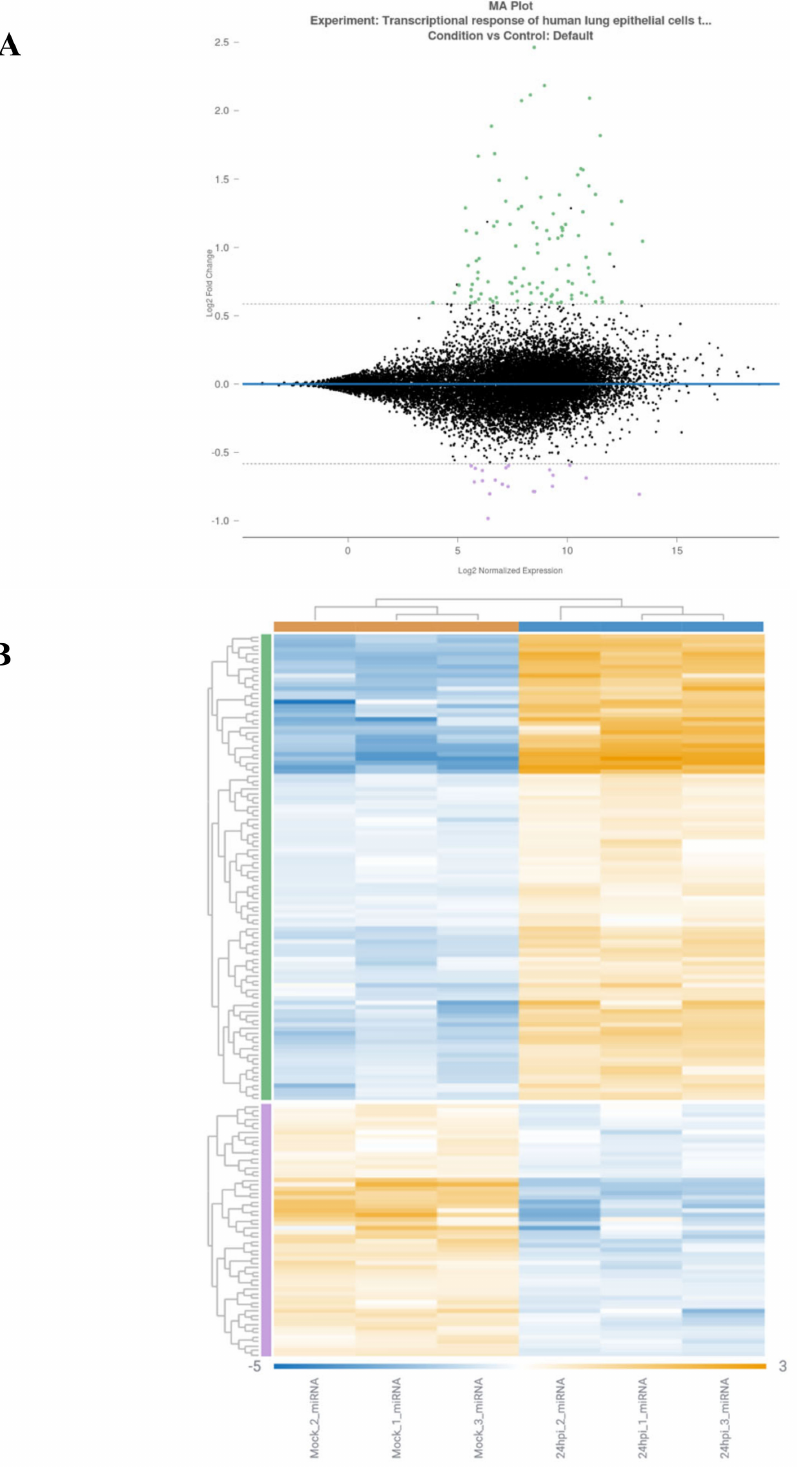
Figure 2. Rosalind meta-analysis for Bioproject PRJNA615032 was used for di ff erential gene expression between SARS-CoV-2-infected NHEB and A549 cells with their (mock treated) controls ( n = 3). 1.5 fold change was accepted as threshold value. (A) MA plot view of di ff erential expression of upregulated and downregulated genes. (B) Heatmap analysis of each clone for 204 di ff erentially expressed gene